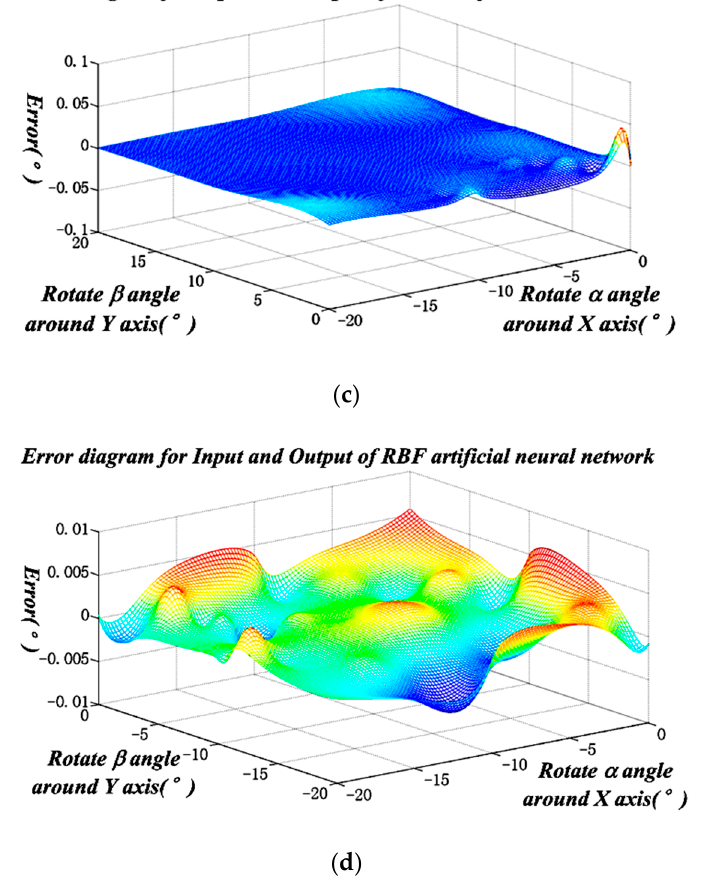
Figure 6. Output error diagrams of the BP ANN with different hidden layers. ( a ) Error of rotation angle α in the first interval; ( b ) error of rotation angle α in the second interval; ( c ) error of rotation angle α in the third interval; ( d ) error of rotation angle α in the fourth interval.